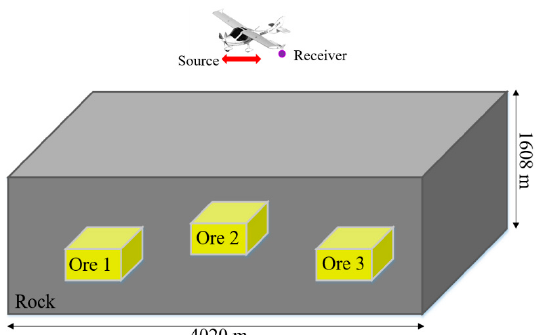
Figure 1. The geometry for a 2-layer medium with three cubic ores in a half space. Three ore mines (201 m × 201 m × 201 m cubes) are located in the rock region, and their centers of position locate at (2010, 1742, 737) m, (2010, 2010, 804) m, (2010,